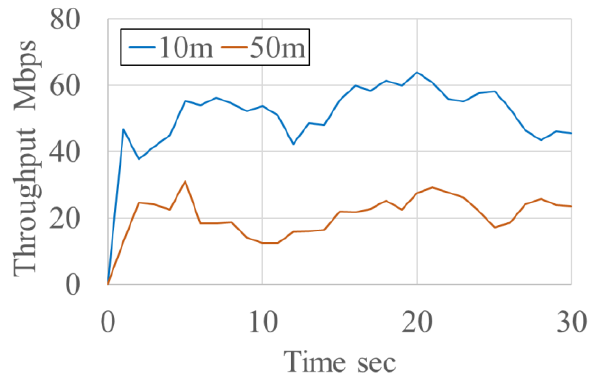
Figure 15. Average UDP throughput in each direction: The blue line is the results when the PC is the sender, and the orange line is the results when the controller is the